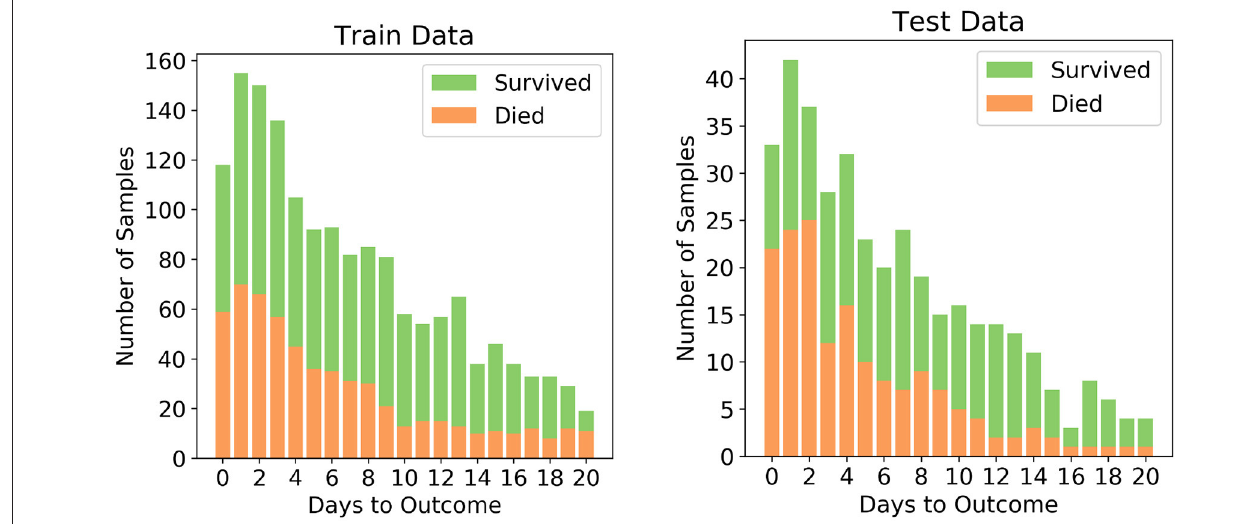
FIGURE 1 | Distribution of the two classes in the train and test sets after splitting.